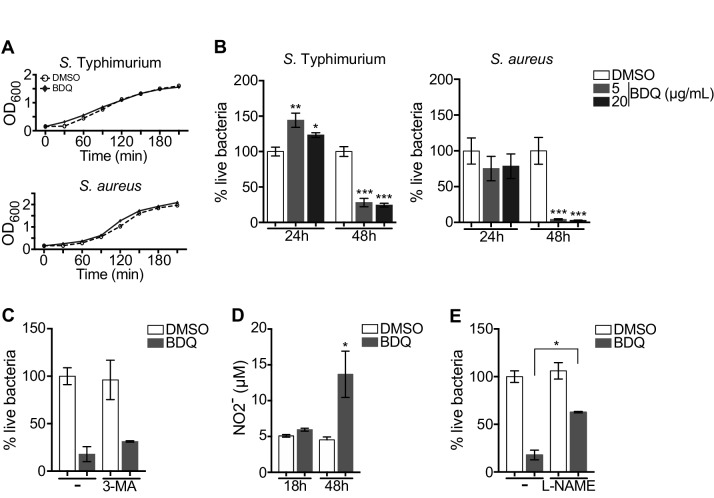
BDQ increases macrophage bactericidal functions.(A) Growth of S. Typhimurium and S. aureus in liquid medium in the presence of BDQ (20 μg/mL). (B) Macrophages were incubated with BDQ and then infected with S. Typhimurium or S. aureus. The number of intracellular bacteria was enumerated at 24 hr post-infection. (C) BDQ-treated macrophages were incubated with 3-MA and then infected with S. aureus. The number of bacteria was counted as previously. (D) Quantification of NO2- in the supernatant of macrophages incubated with BDQ for 18 hr and 48 hr. (E) Cells were treated as in (C), 3-MA was replaced by L-NAME (0.1 mM), an inhibitor of nitric oxide (NO) synthesis. One representative experiment (of three) is shown. Error bars represent the mean ± SD. Unpaired two-tailed Student’s t test was used. *p<0.05, **p<0.01, ***p<0.001.